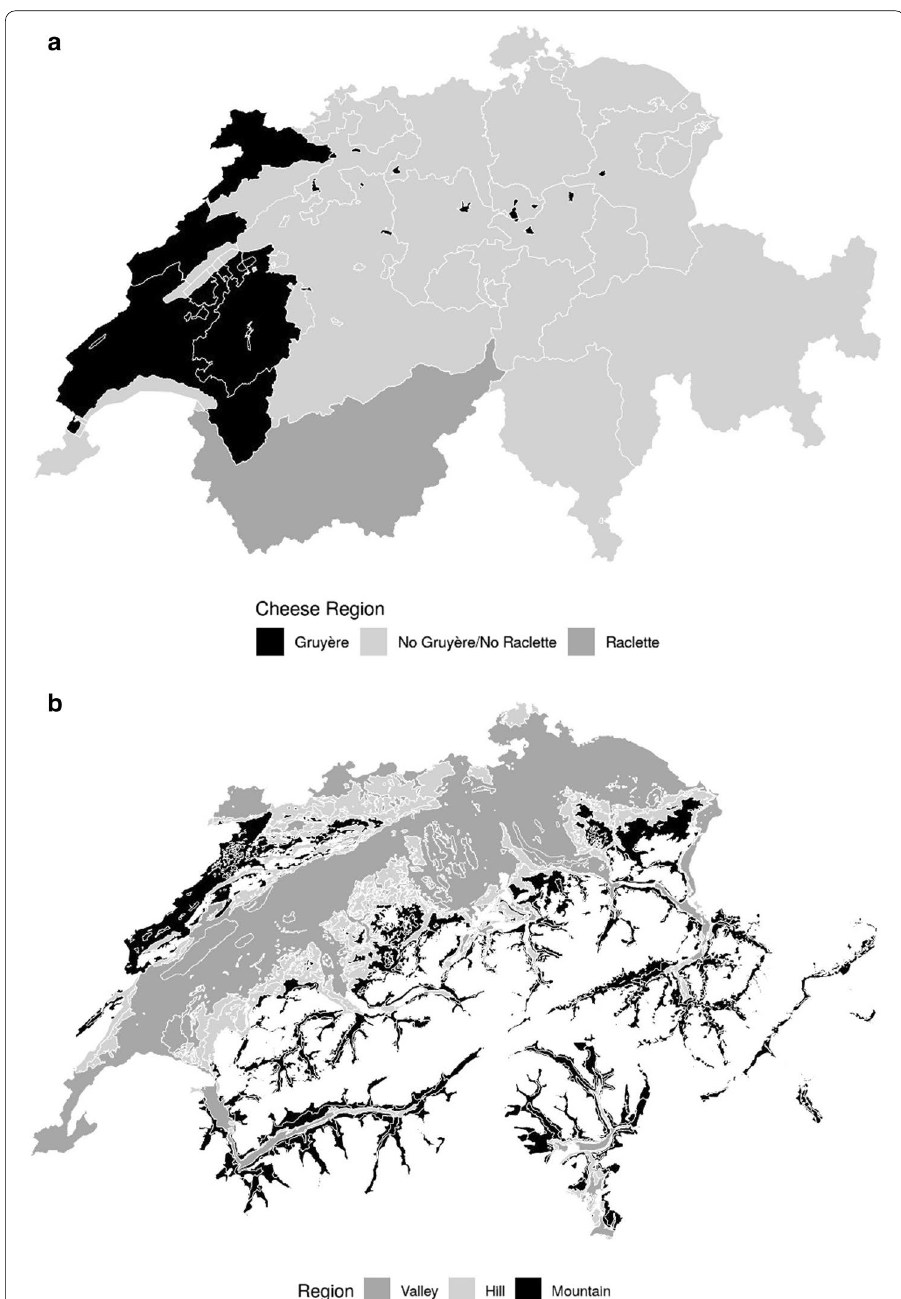
Fig. 1 Regional characteristics. a Switzerland’s cheese regions, b Switzerland’s agricultural regions. Source : Authors’ illustrations using data from https:// map. geo. admin.